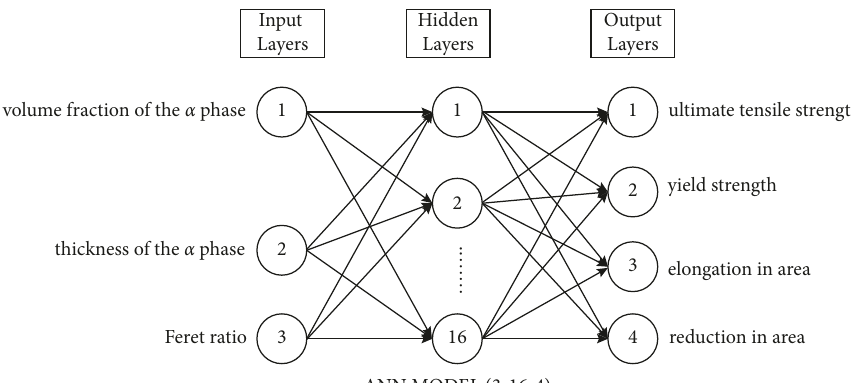
Figure 16: Overview of an ANN